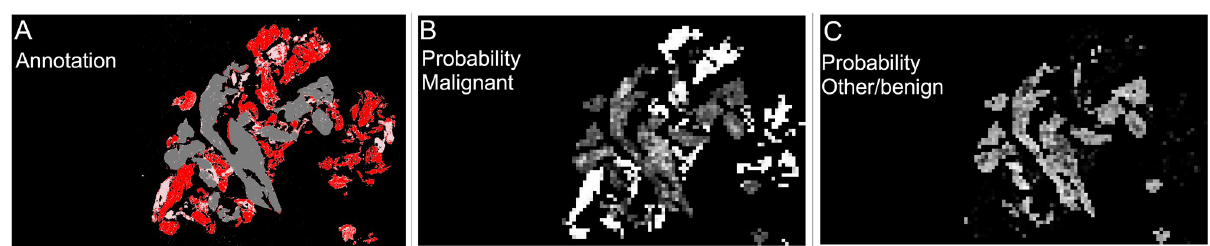
Fig 6. Heatmaps of patch level results for slide shown in Fig 4a, and annotated results for comparison. Slide is from the validation set. (A) Annotation, black is background, pink is “blood or mucus”, grey is “other or benign”, red is “malignant”. This is a repeat of Fig 4f. (B) “Malignant” heatmap of patch results, white is probability of being “malignant” is 1, black is probability of being “malignant” is 0. (C) “Other or benign” heatmap of patch results, white is probability of “other or benign” = 1, black is probability of “other or benign” =